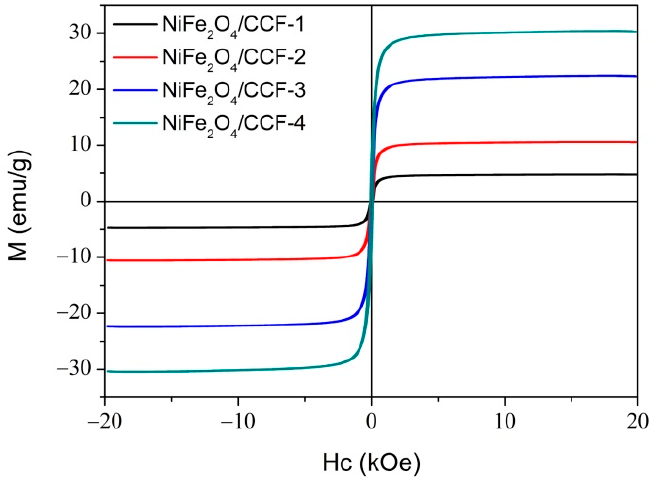
Figure 4. TG curves of NiFe 2 O 4 /carbonized cotton fibers in air atmosphere. To study the magnetic properties of NiFe 2 O 4 /CCF-1, NiFe 2 O 4 /CCF-2, NiFe 2 O 4 /CCF-3, and NiFe 2 O 4 /CCF-4, we measured the hysteresis loops at room temperature within the magnetic field of − 20 kOe–20 kOe, as shown in Figure 5. It can be seen that these four samples all show ferromagnetic behavior. The saturation magnetization ( M S ) of NiFe 2 O 4 /CCF-1, NiFe 2 O 4 /CCF-2, NiFe 2 O 4 /CCF-3, and NiFe 2 O 4 /CCF-4 is 4.7 emu/g, 10.5 emu/g, 22.3 emu/g, and 30.3 emu/g, respectively. It is obvious that the M S increases with the increase in the loading amount of NiFe 2 O 4 nanoparticles, and this result is consis- tent with the XRD, SEM, and TG results.